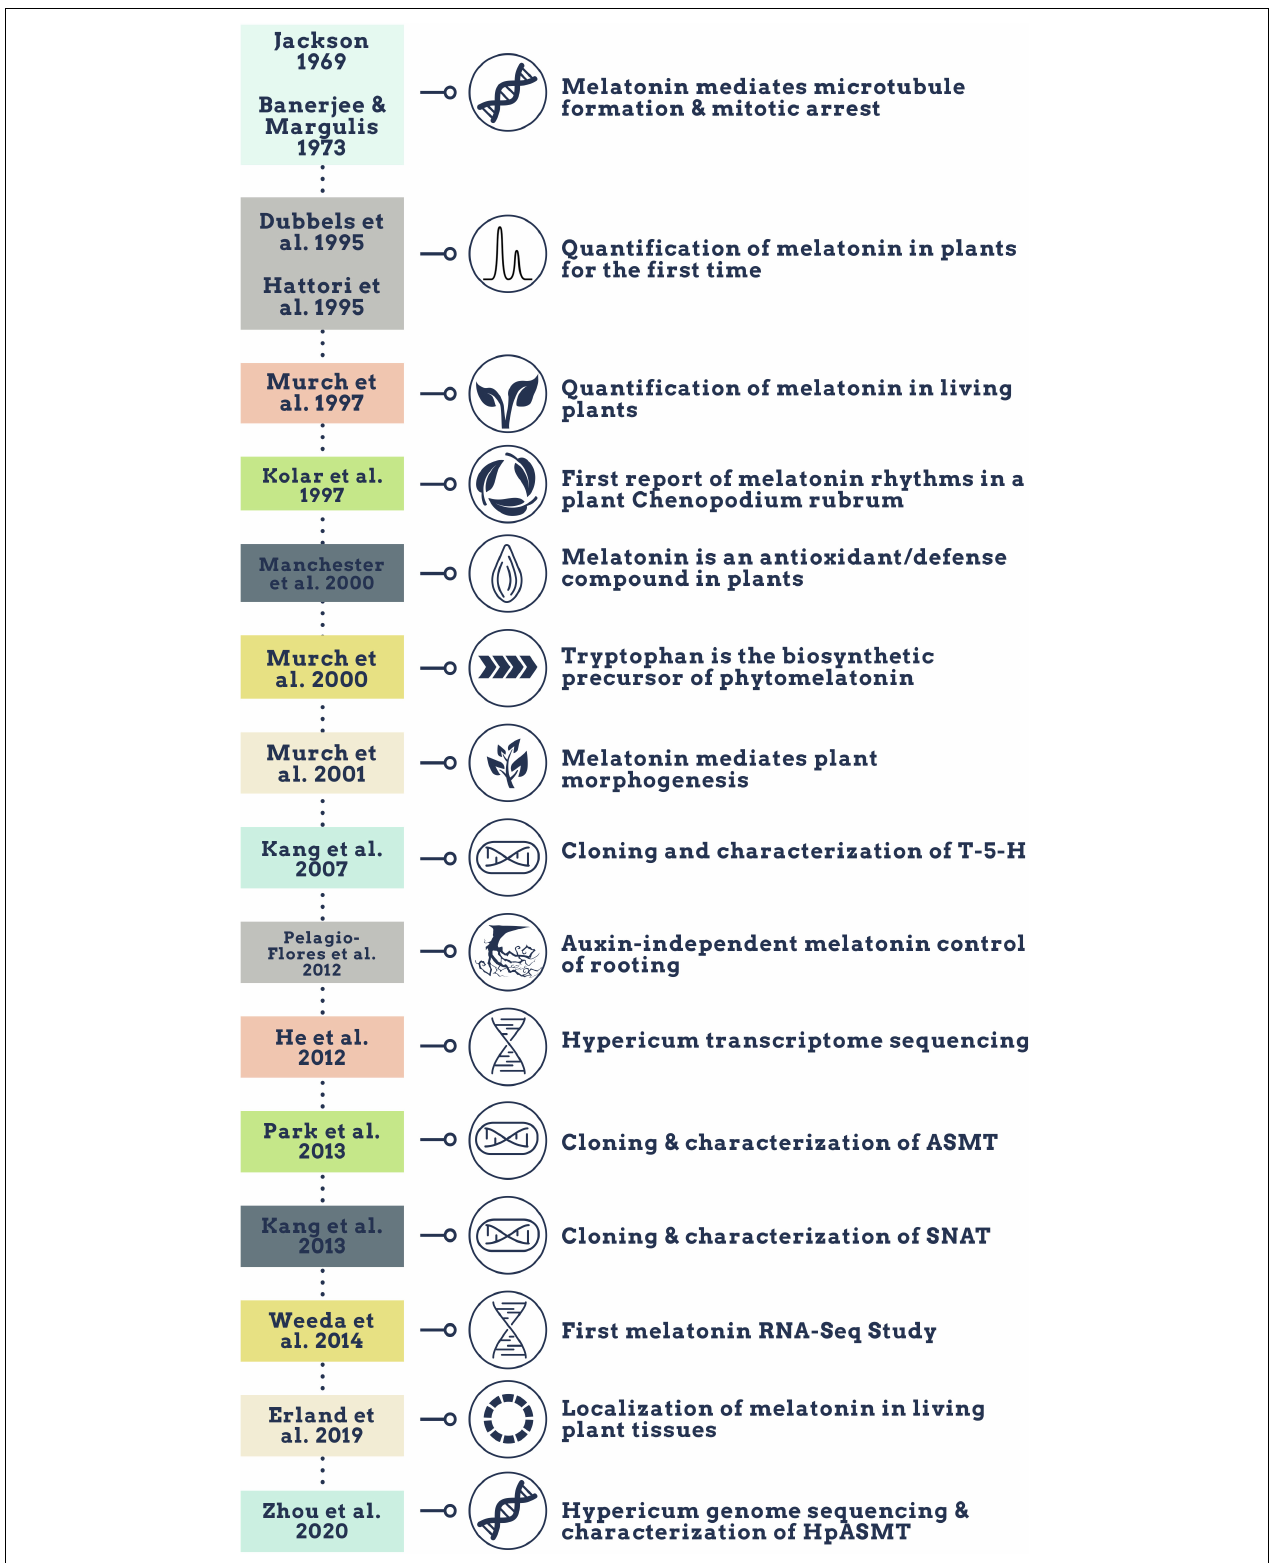
FIGURE 1 | Timeline of qualitative major melatonin research developments.